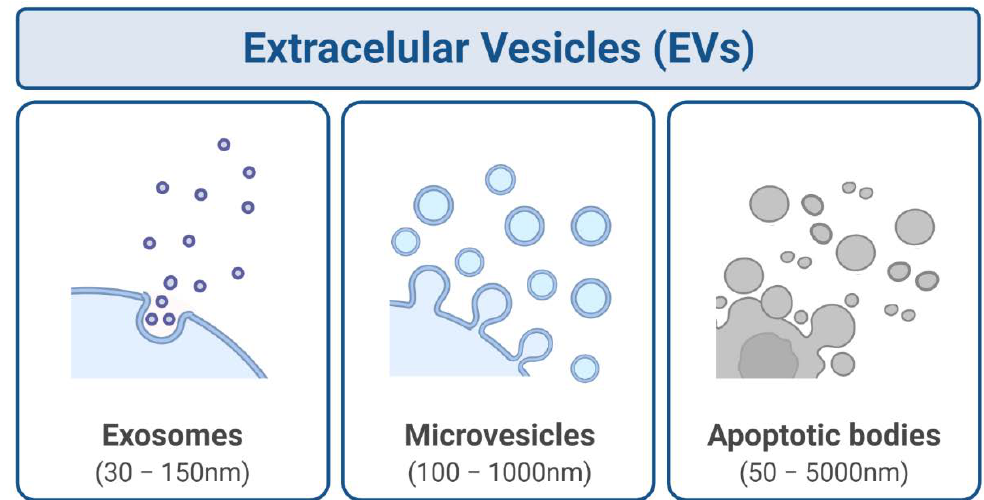
Figure 1. Extracellular vesicles (EVs) can be classified into exosomes, microvesicles, and apoptotic bodies, according to their size and biogenesis mechanism. Created with BioRender.com.